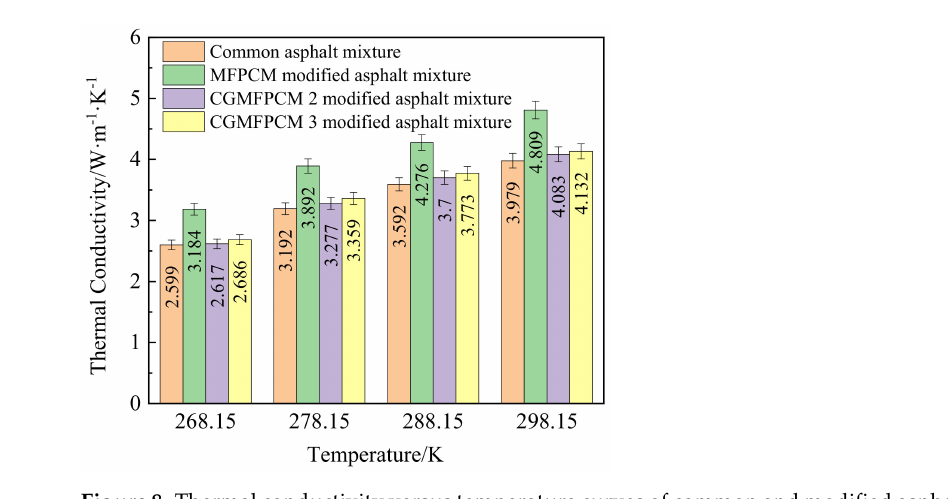
Figure 8. Thermal conductivity versus temperature curves of common and modified asphalt mixtures.